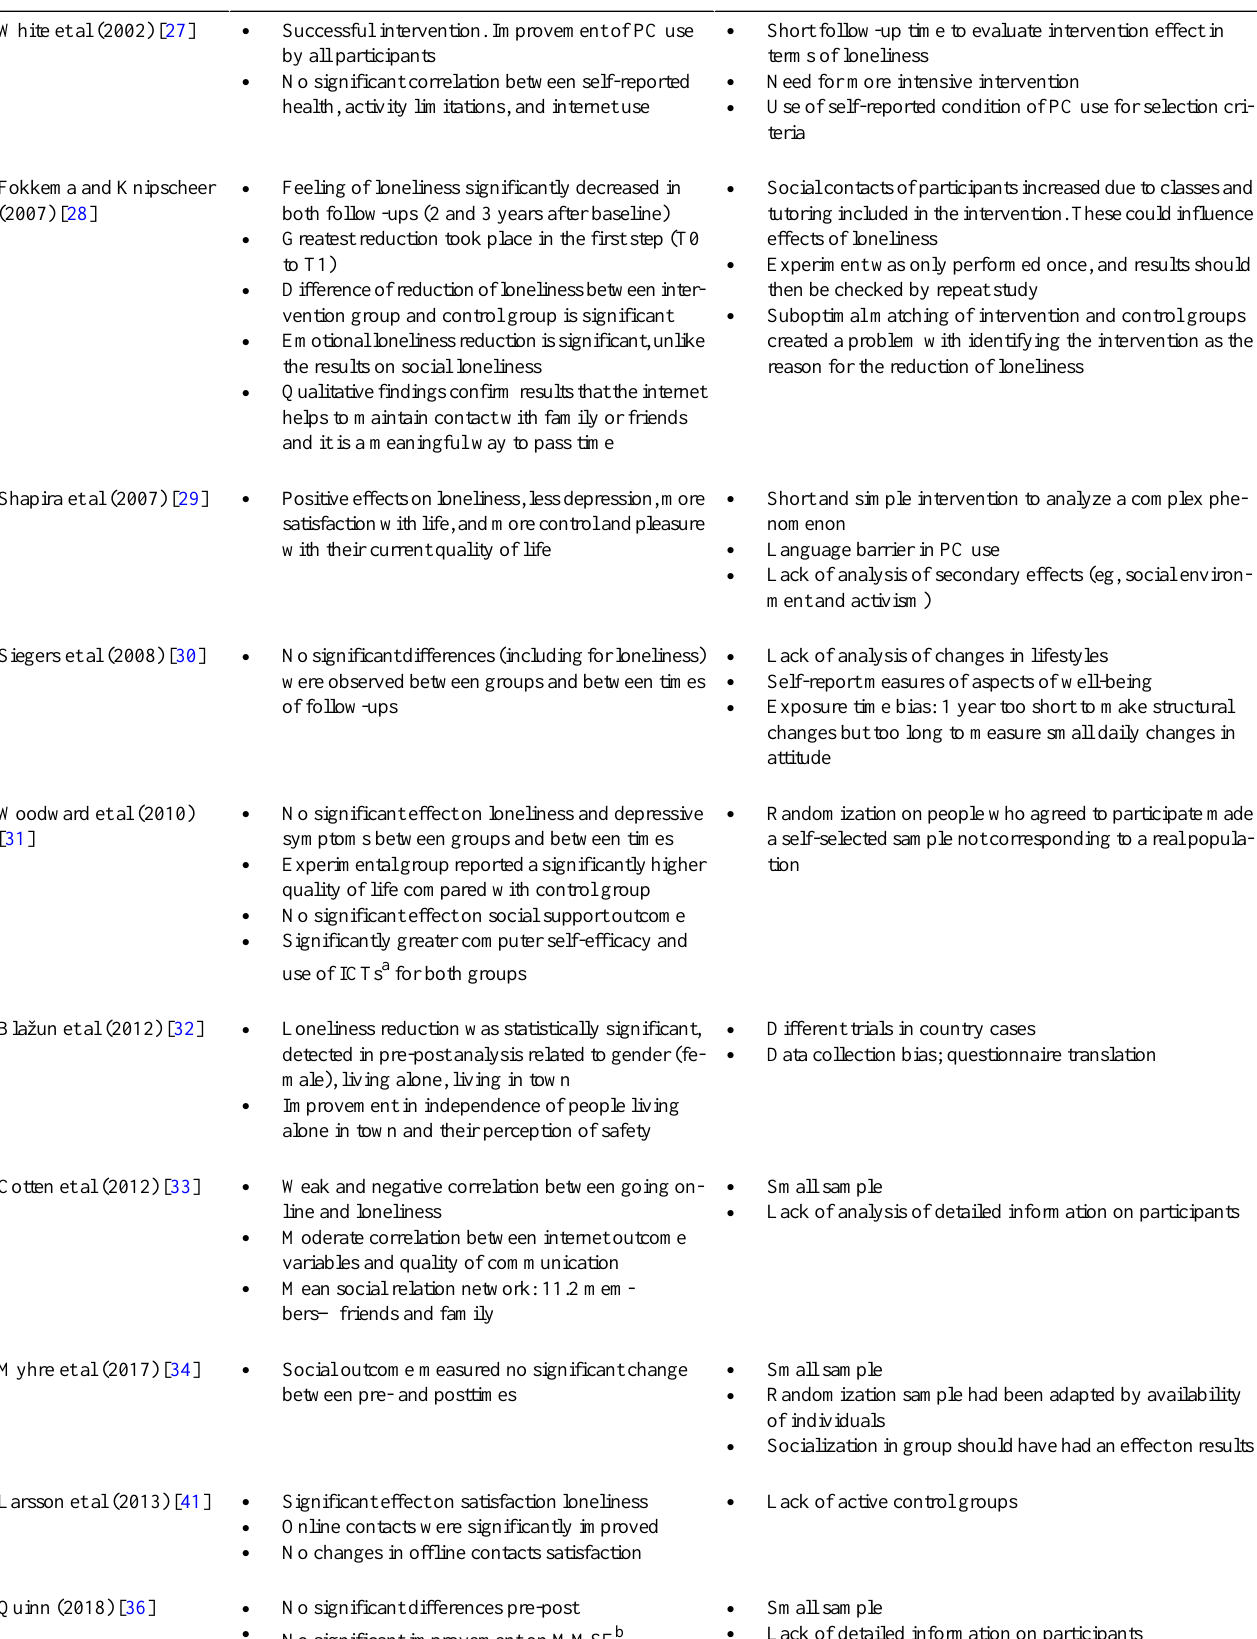
Table 4. Contents of studies: findings and limitations. LimitationsResultsAuthor name and